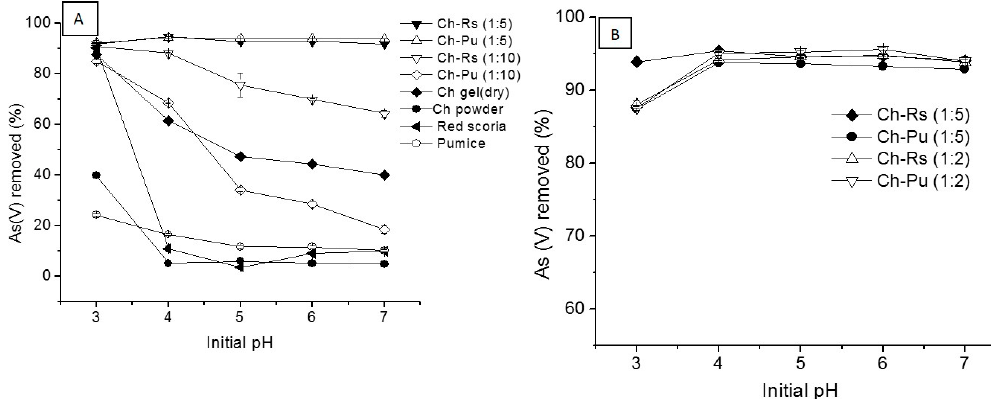
Figure 3. Removal of As (V) by different adsorbents: ( A ) As(V) concentration of 1.0 mg/L, 20 g/L adsorbent dose, shaking for 24 h, at 24 ± 1 °C, ( B ) As(V) concentration of 0.25 mg/L, 8 g/L adsorbent dose, shaking for 2 h, at 24 ± 1 °C.